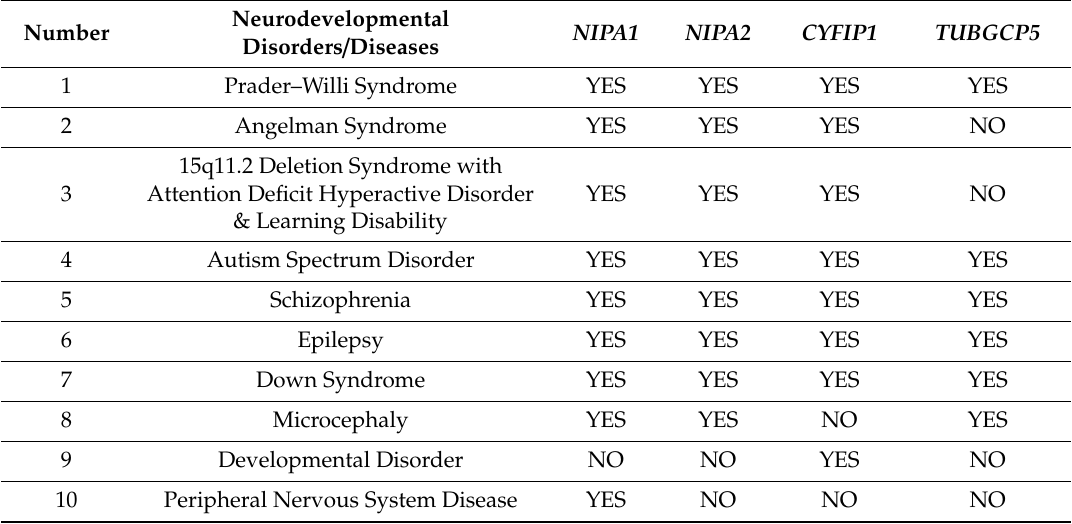
Table 16. Summary of Associated Neurodevelopmental Maladies Across All Four Genes. Neurodevelopmental NIPA1 NIPA2 CYFIP1 TUBGCP5 Number Disorders / Diseases Prader–Willi